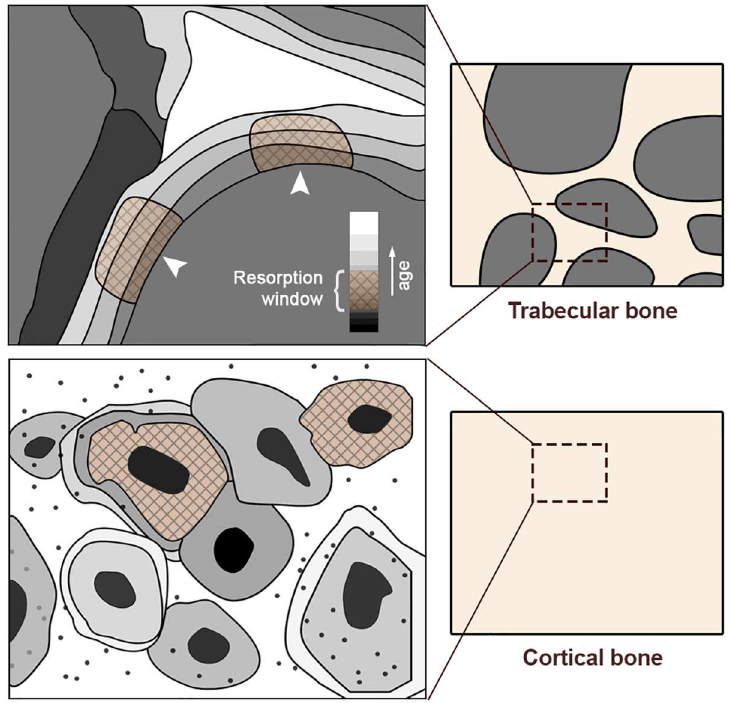
Fig 4. Plot representing a reference bone volume (right) formed by solid matrix and pores. A magnifyingbox honingin on specific trabeculae(left) shows a mosaic of tissue structural units presenting a distribution of mineral content dependingon bone age (grayscale, darker means youngerand less mineralized). Since resorptionis assumed to be performed preferablyat the bone surface, a resorption temporalwindowis defined(shadedareas with stripes). The organizationof the trabeculaein layers with growingmineral content is basedon results by Lukas et al.[29]. Also, there is experimental evidenceof the layer-likeorganization in compact boneas can be seen in the work by Boivin et al.[36]